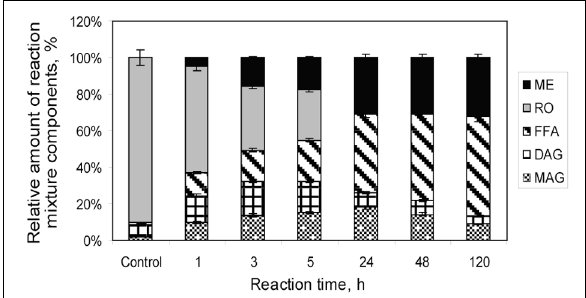
Fig. 3. Effect of reaction time on Lipoprime 50T-catalyzed rapeseed oil methanolysis with 1:4 rapeseed oil to methanol molar ratio at 30 °C in n- hexane. Control – RO. Symbols are the same as in Fig. 2